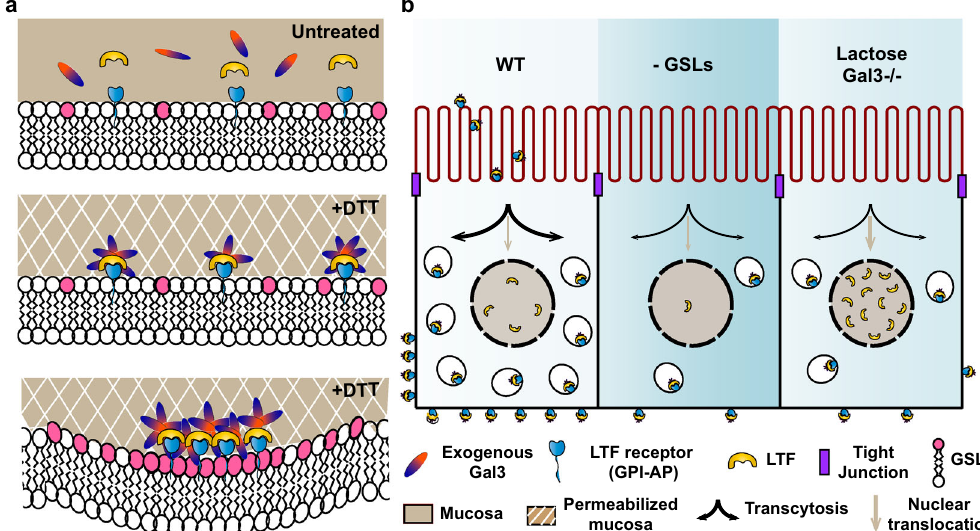
Fig. 8 The GL-Lect hypothesis in mouse intestinal epithelium. a Schematic representation of the GL-Lect hypothesis 9 transposed to the apical surface of enterocytes of the jejunum. In the absence of DTT-mediated permeabilization of the mucus, exogenous Gal3 and LTF do not gain access to the apical membrane surface and remain trapped in the mucus (top scheme). Upon DTT-mediated permeabilization of the mucus, monomeric Gal3 is recruited to apical membranes by binding to glycosylated cargo proteins on microvilli, such as LTF (middle scheme). Membrane-bound Gal3 oligomerizes and gains the functional capacity to interact with GSLs to drive membrane bending (bottom scheme). Gal3-mediated co-clustering of glycosylated cargo proteins and GSLs drives the formation of tubular endocytic pits from which CLICs are formed. b Schematic representation of the outcomes of the current study. Left: Transcytosis in control conditions. Middle: Under GSL depletion conditions, GL-Lect endocytosis of LTF is inhibited, leading to reduced transcytosis. Right: Under Gal3 KO conditions or in the presence of high lactose concentrations, GL-Lect endocytosis and transcytosis of LTF are inhibited, while LTF targeting to the nuclear region appears to be increased. See text for